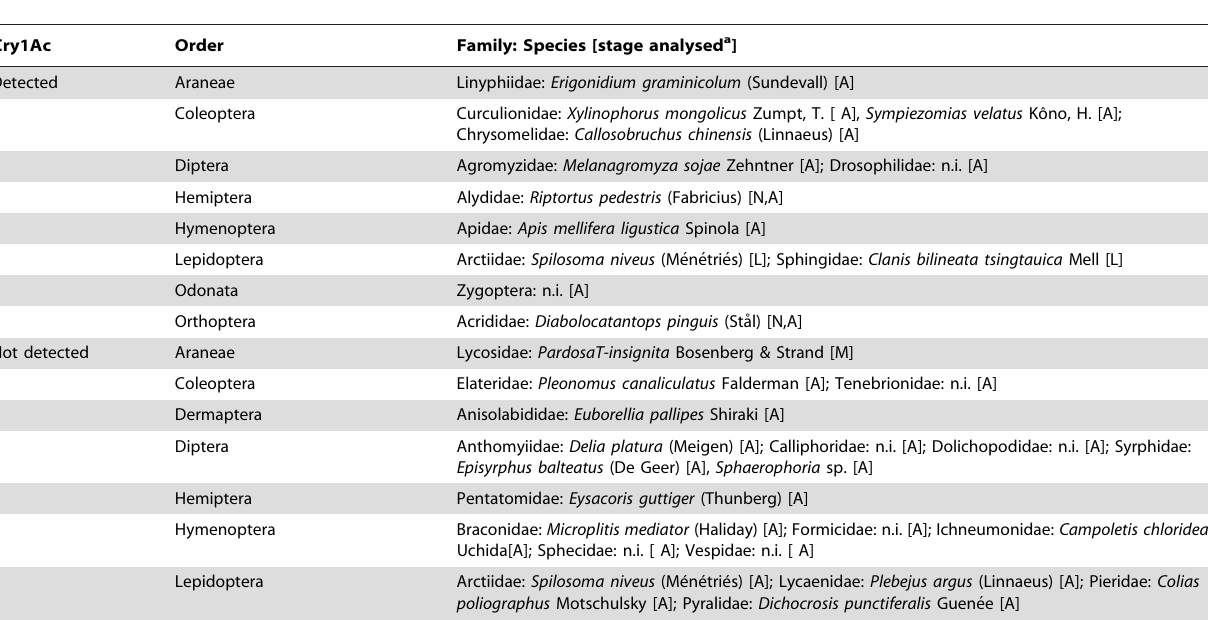
Table 2. Detection of Cry1Ac in arthropods collected from Bt soybean plots at different growth stages for which only one or two sub-samples were analysed (by ELISA).